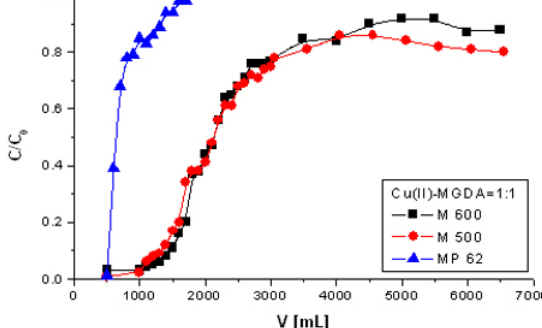
Figure 6. The breakthrough curves of Cu(II) complexes with MGDA on Lewatit MonoPlus M 600, Lewatit MonoPlus M 500 and Lewatit MP